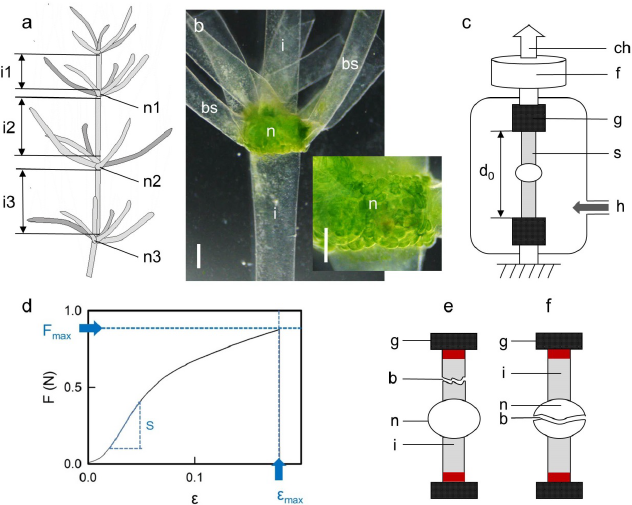
Fig. 1: Tensile test for stem samples of Chara corallina . a: Sketch of thallus with internodes (i) and nodes (n); b: Microscopic view of thallus with node (n) with internodes (i) and branching stems (bs) as prepared for immunolabelling, detail = multicellular node, bars = 0.5 mm; c: Setup of tensile test, ch = cross head, f = force transducer, g = grip, s = specimen, d 0 = grip distance, h = humidifier for control of relative humidity; d: Representative plot of force (F) versus strain (ε). The maximum force (F max ) corresponded to the maximum force recorded, the maximum strain ( ε max ) to the strain at F max . The stiffness (S) cor- responded to the maximum slope. e, f: Failure of the internode or node using node samples, b =